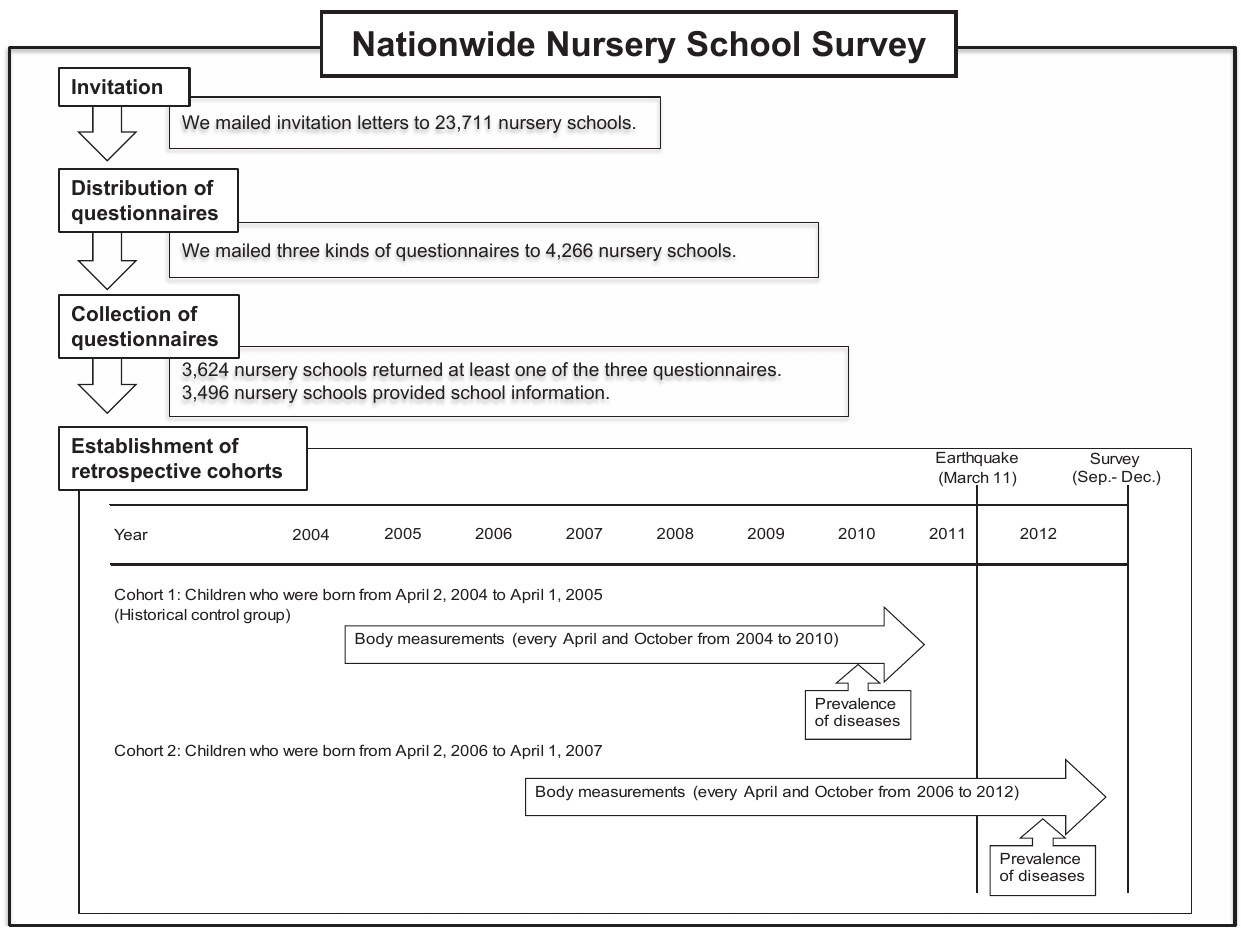
Figure 2. Flow of the Nationwide Nursery School